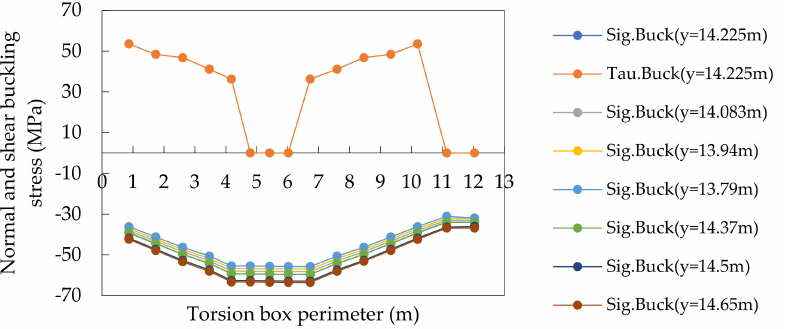
Figure 11. Evolution of elastic buckling stress, normal ( Sig.Buck ) and shear ( Tau.Buck ), along the perimeter of the torsion box for the different values of the width variable.